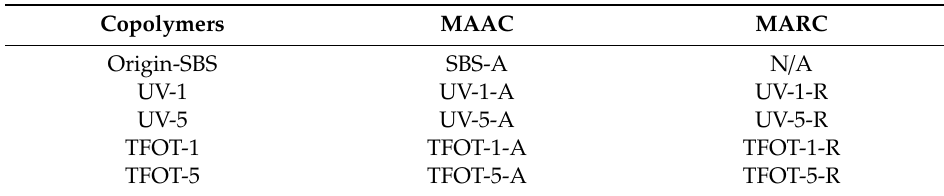
Table 5. Labels of asphalt